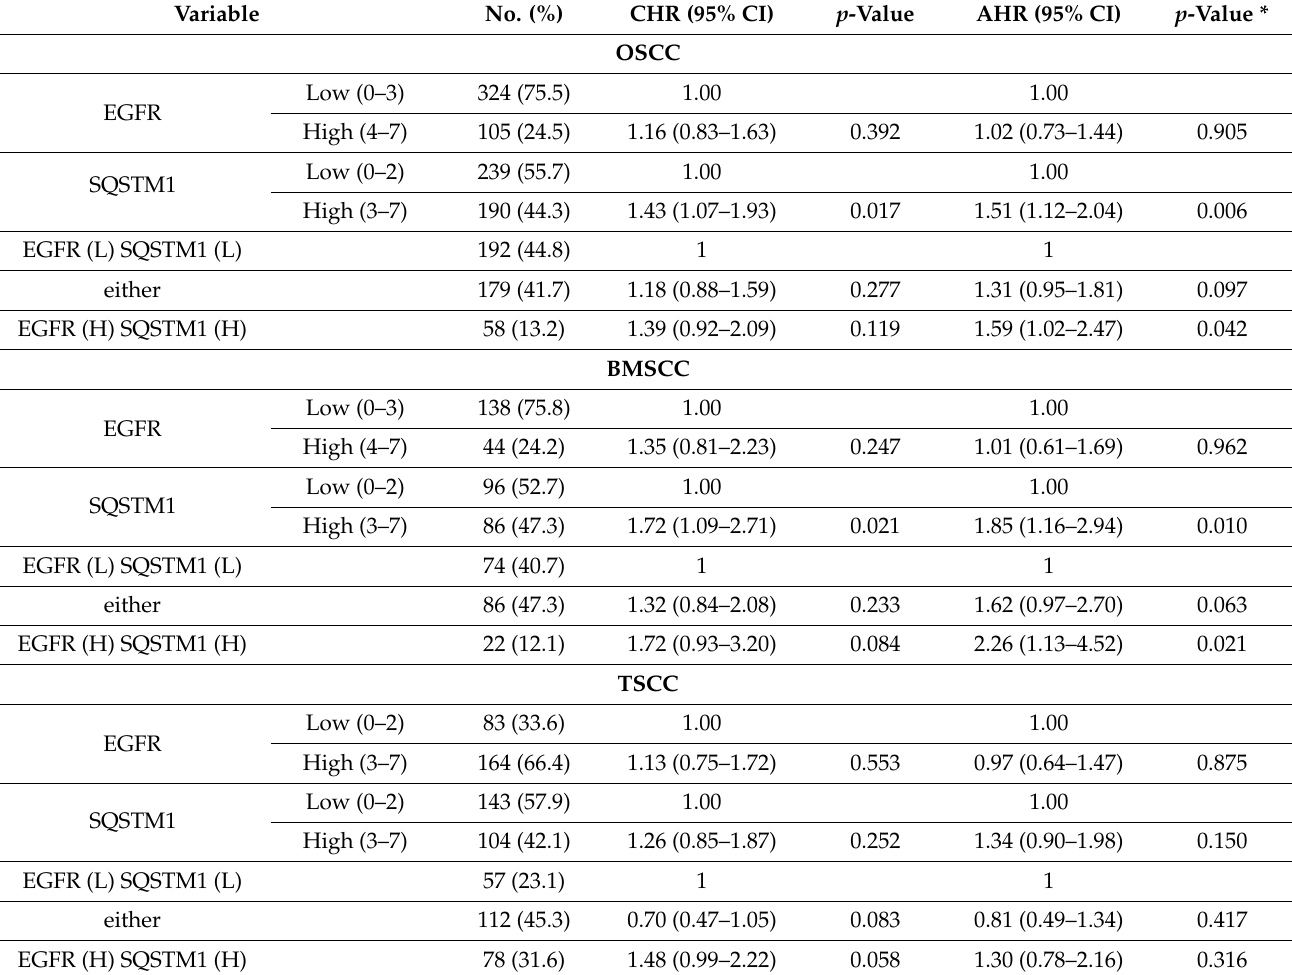
Table 2. The co-expression of EGFR and SQSTM1 in disease-specific survival of OSCC